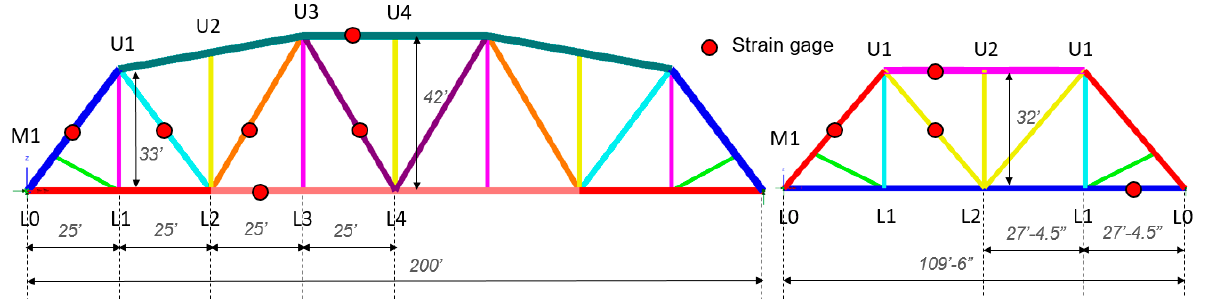
Figure 3. Investigated truss bridge dimensions and strain gauge locations (1 ft = 0.305 m). Table 1. Geometry properties of truss members. Bottom Chords and Diagonals Top Chords and End Posts